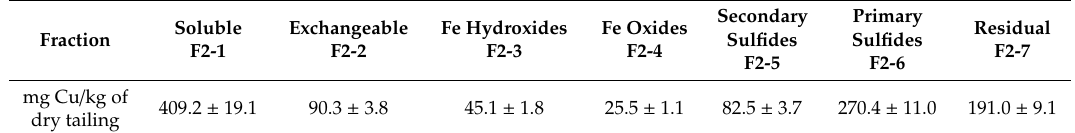
Table 2. Copper concentration in mg Cu / kg dry tailing in each fraction. Sample analyzed by the seven-fraction